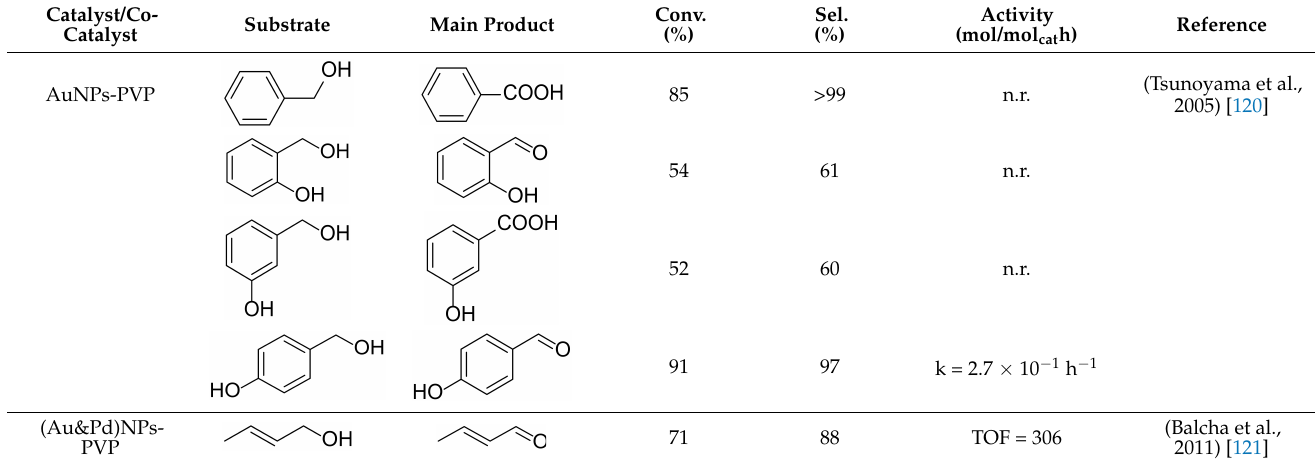
Table 3. Aerobic alcohol oxidations promoted by polymer supported